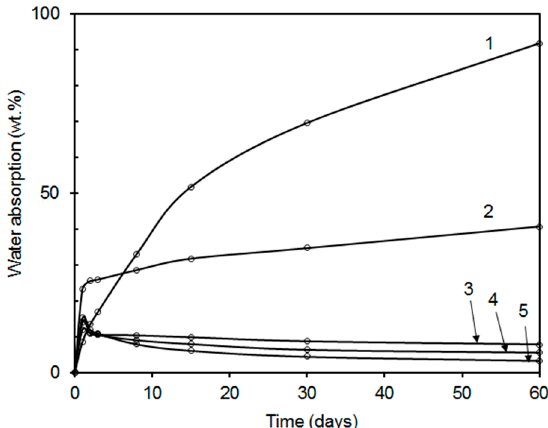
Figure 8. Water absorption into coatings prepared from the latexes containing MgO-based nanoparticles: sample L 0 without nanoparticles (curve 1); sample L MgO-0.5 (curve 2); sample L MgO-1.0 (curve 3); sample L MgO-1.5 (curve 4); sample L MgO-2.0 (curve 5). The standard deviations of performed measurements were below 2%.